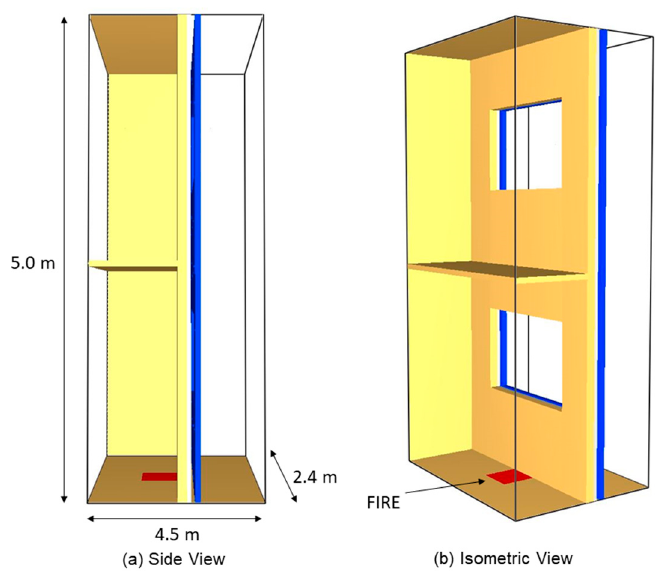
Figure 4. Model configuration.